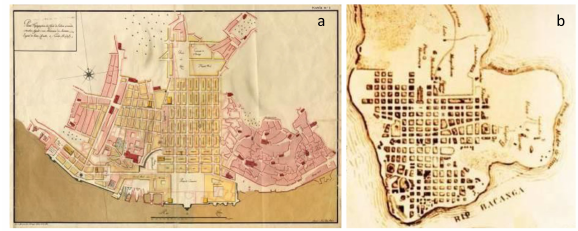
Figure 3. (a) Orthogonal layout of Baixa Pombalina in Portugal, (1756); (b) Orthogonal mesh in S˜ao Lu´ıs. (Figueiredo, 2014)